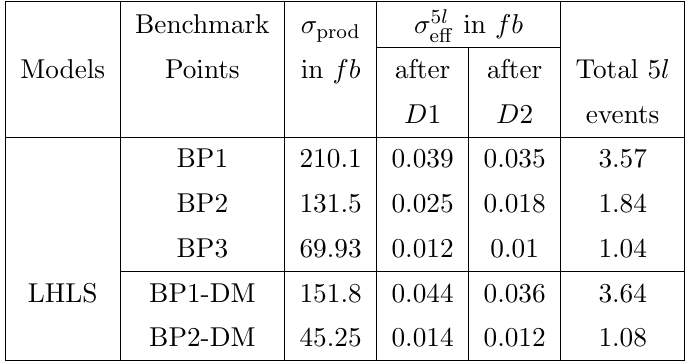
Table 19 . The production cross-sections of all EWeakino pairs and (cid:27) 5 l and table 7. Also the total number of 5 l events are shown for an integrated luminosity of 100 fb (cid:0) 1 .